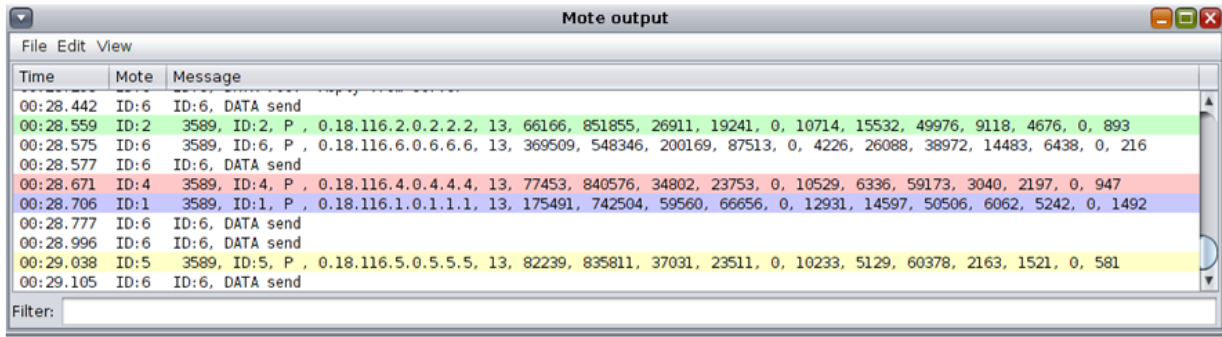
Figure 25. Cooja Simulator —motes’ outputs .